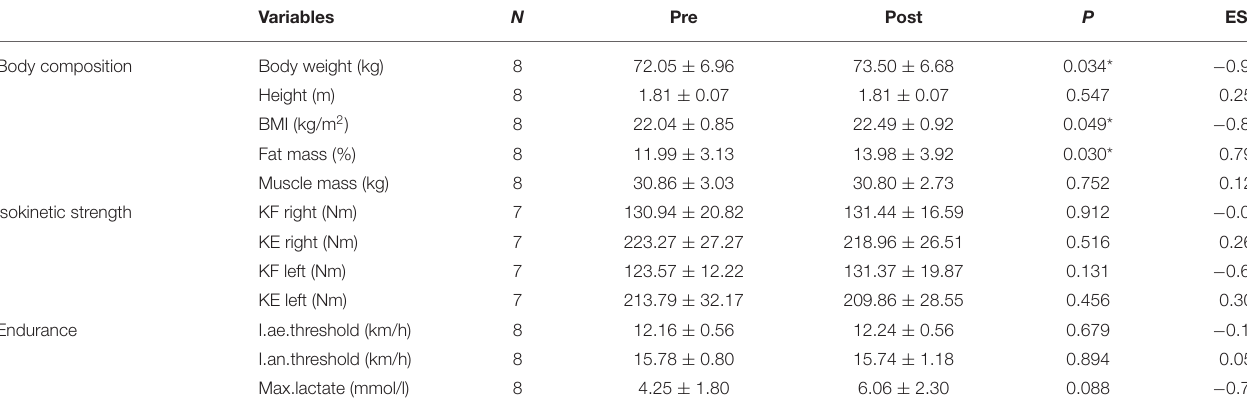
TABLE 3 | Measurements before and after the home training period. Variables N Pre Post P ES Body